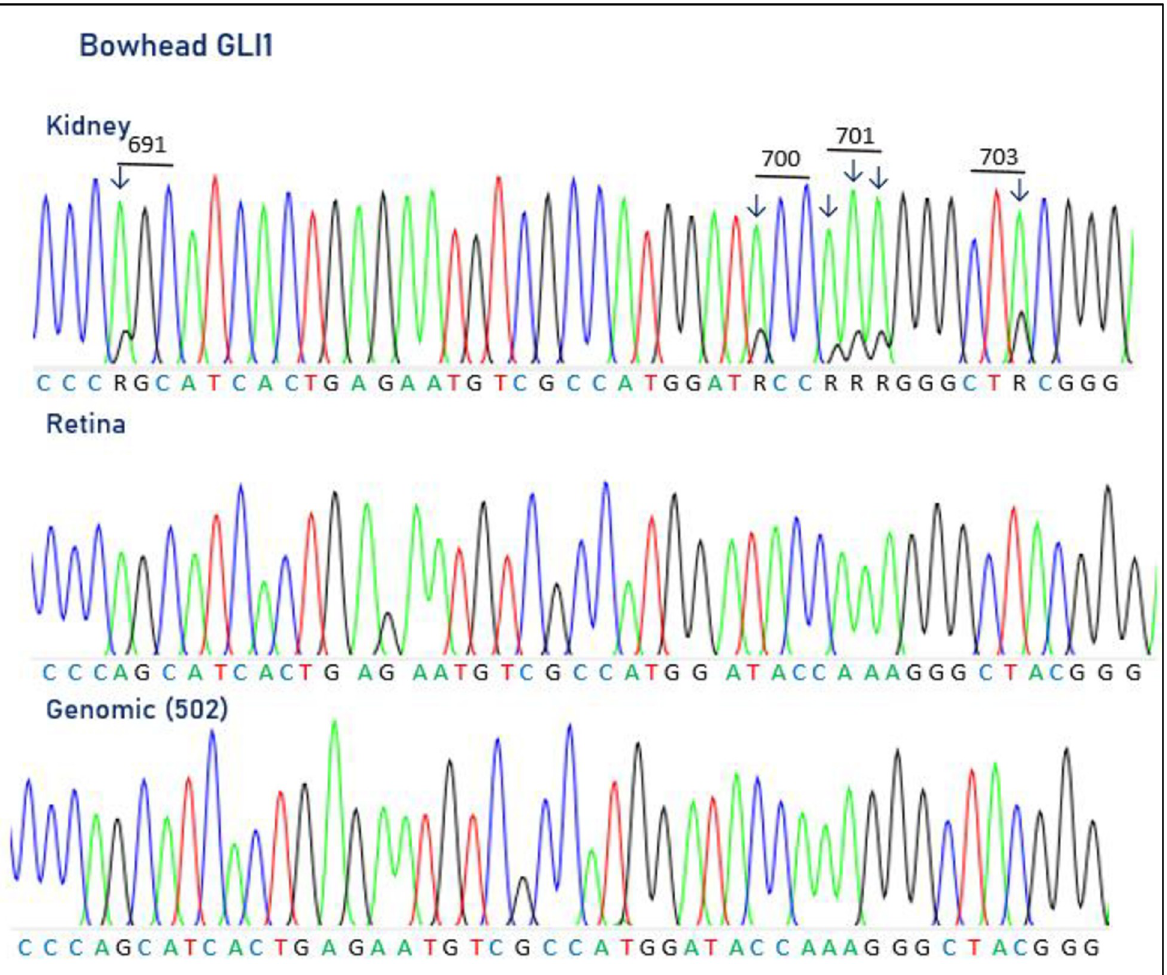
Fig 5. Electropherograms showing GLI1 pre-mRNA editing in bowhead kidney (upper panel) and retina (middle panel). For comparison, the genomic sequence is shown below. Editing is only detected in kidney, where six adenosines, occurring in codons 691, 700, 701 and 703, are edited.